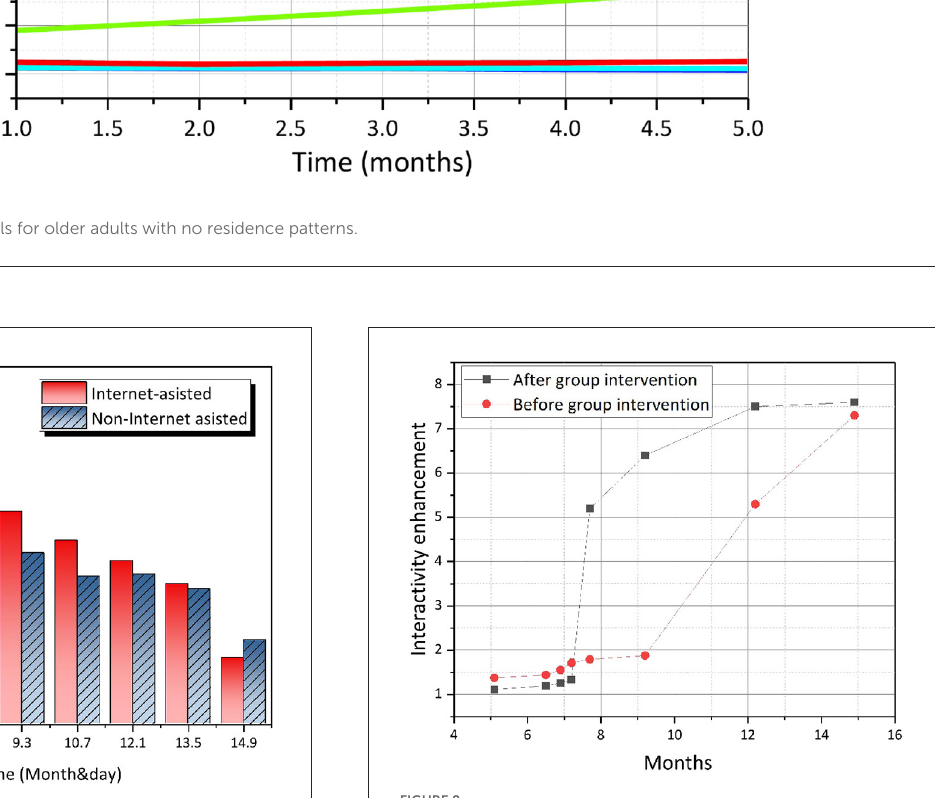
FIGURE8 Basic indicators of adaptation to the network environment before and after the group’s